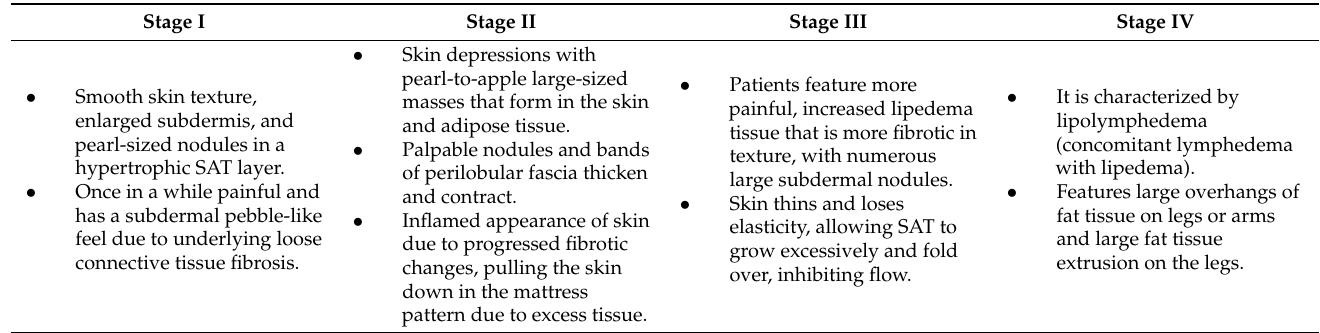
Table 1. Stages of lipedema are categorized based on adipose tissue structure, mobilization pattern, and pathological conditions observed under clinical investigation of patients with